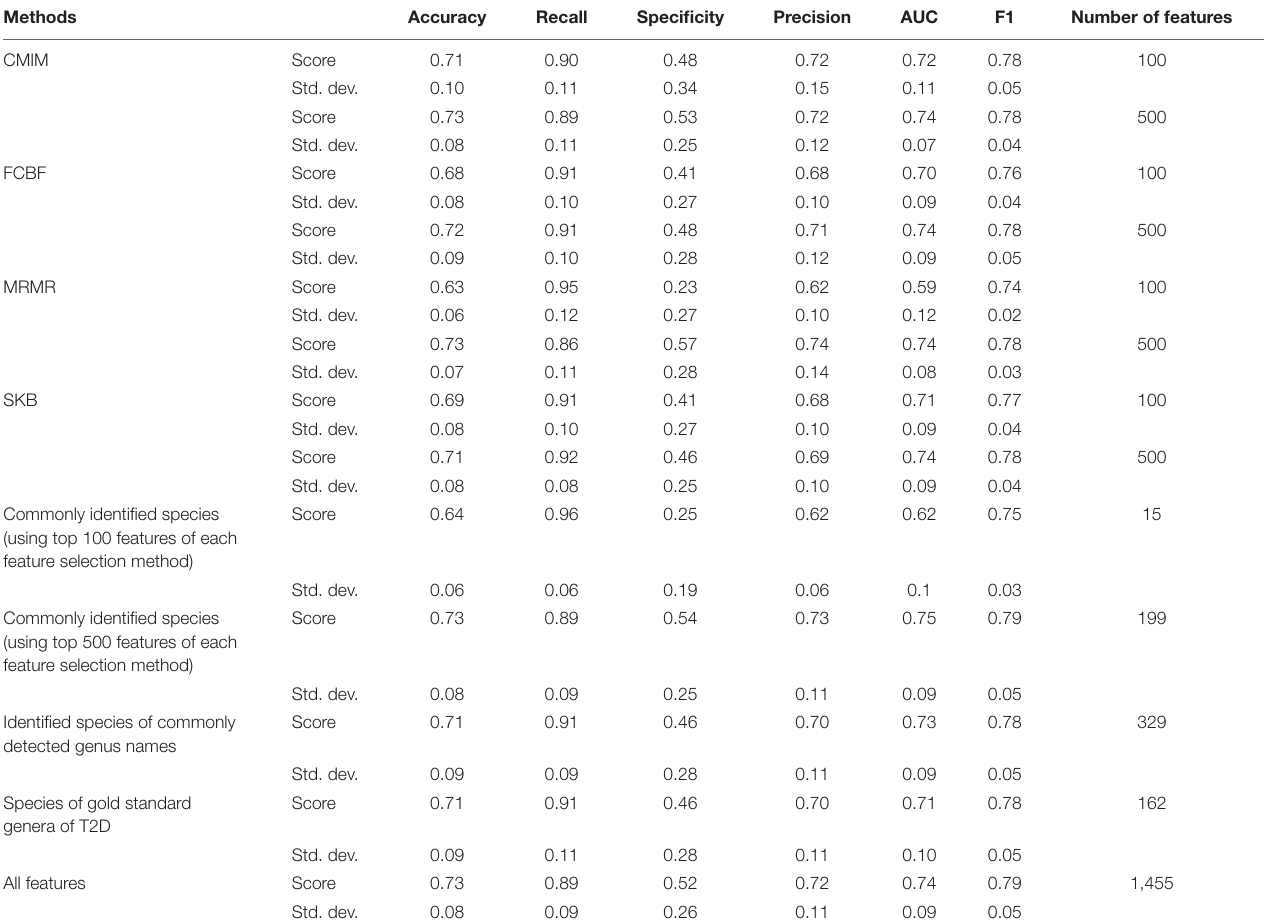
TABLE 2 | Comparative evaluation of the different feature selection methods, based on different performance metrics. Methods Accuracy Recall Specificity Precision AUC F1 Number of features